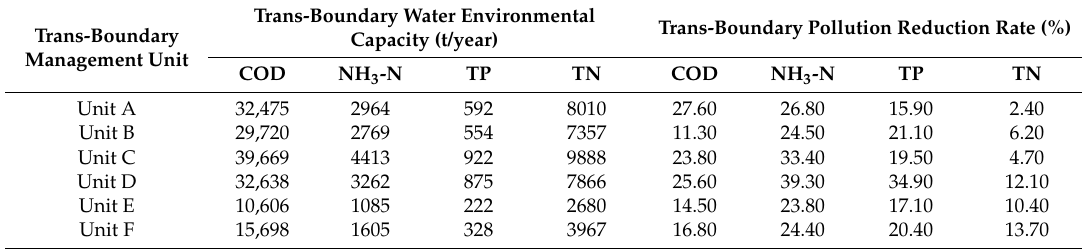
Table 5. Total amount control of pollutant in the trans-boundary effective control area (TECS) of Taihu